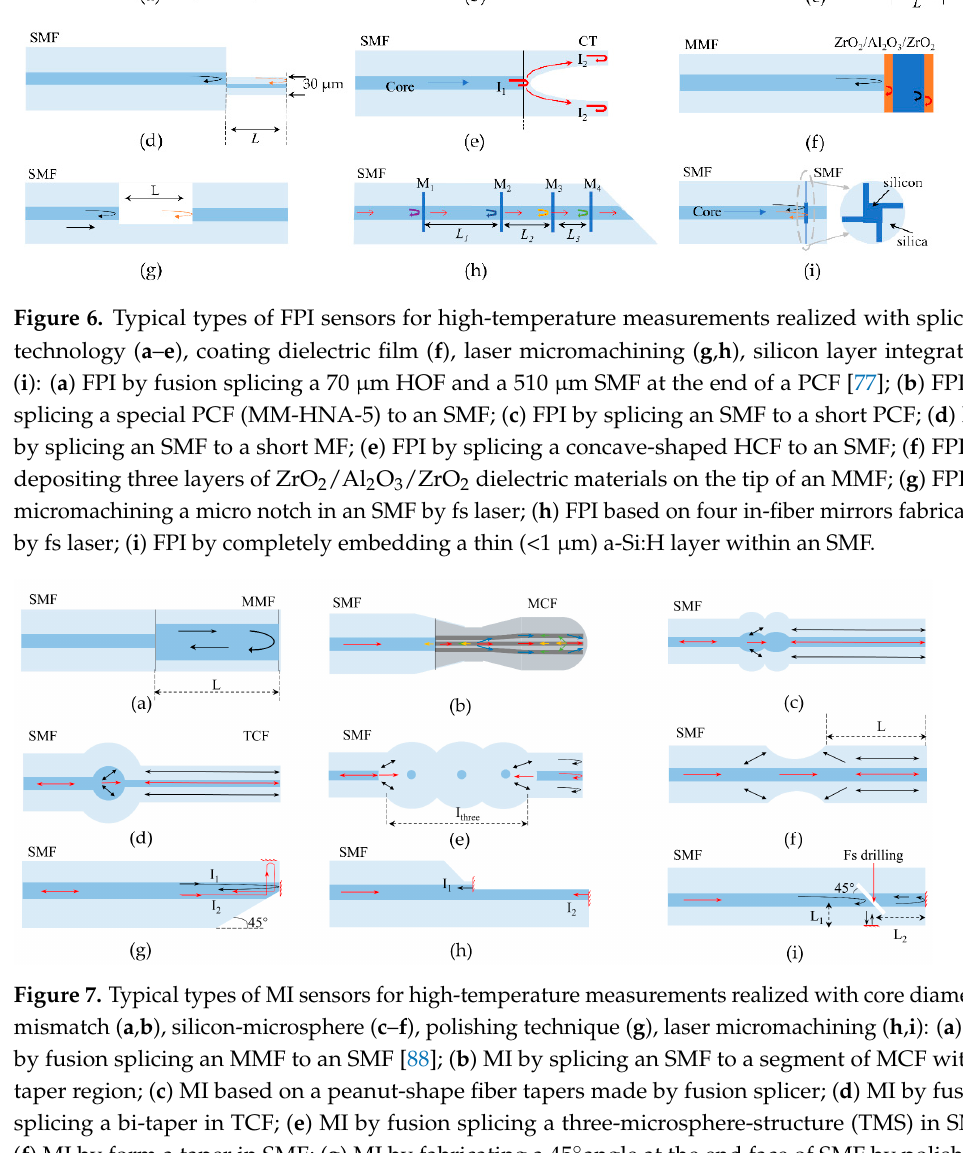
polishing technique; ( h ) MI by cutting a step structure into the fiber at its tip by fs laser; ( i ) MI based on an inclined narrow slit inside SMF.